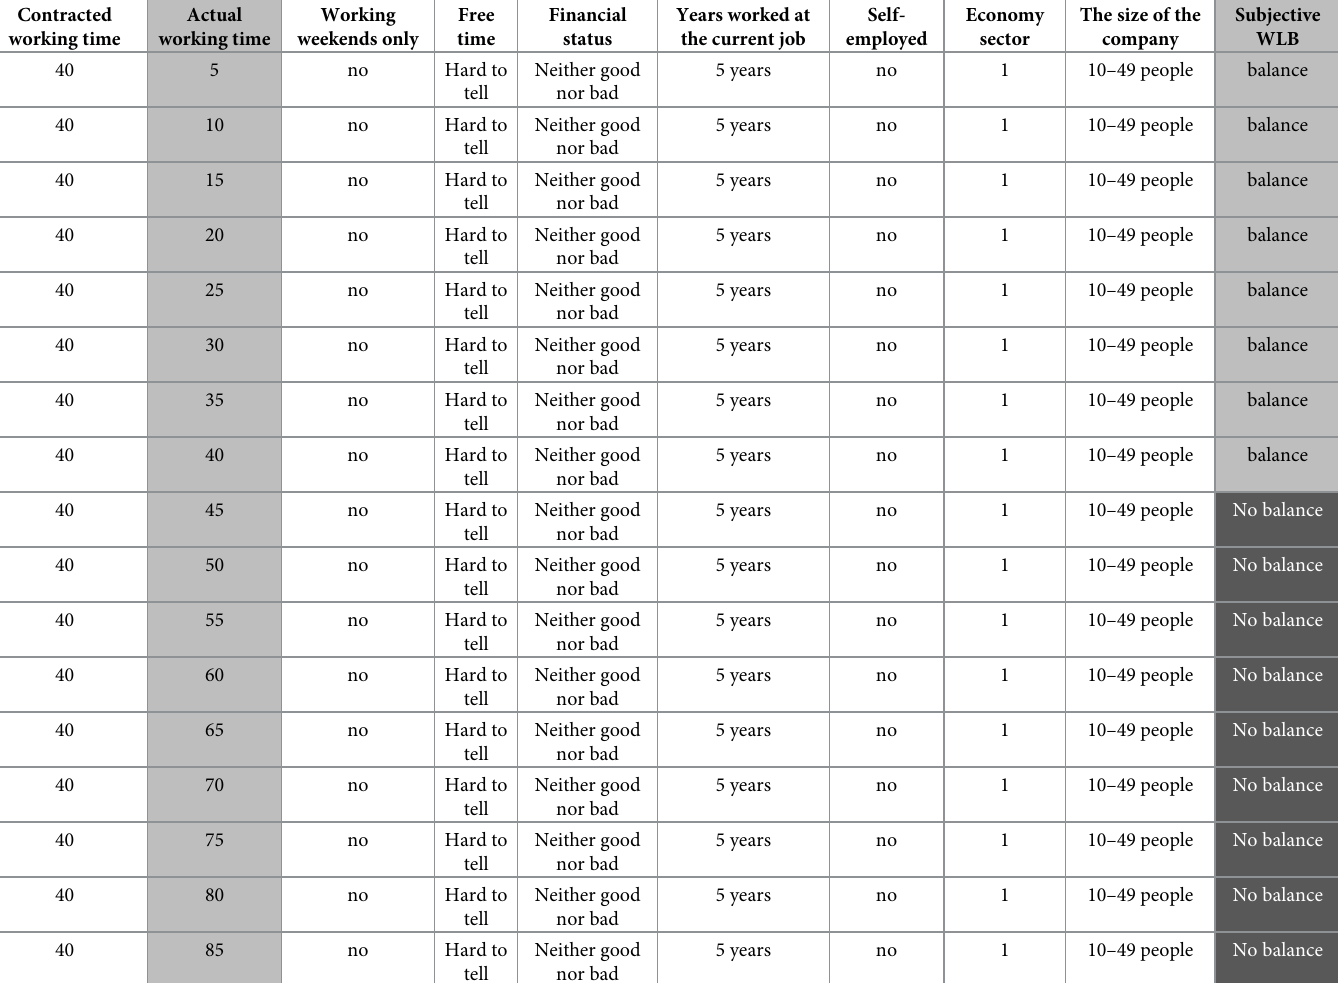
Table 6. The influence of the simulated shifts in working time on subjective WLB according to the ANN. Contracted working